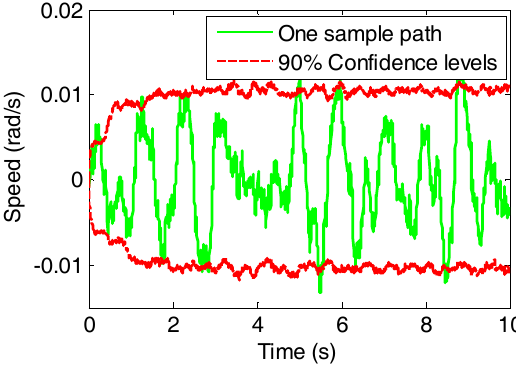
Figure 7. The rotor speed response of the sSMIB.